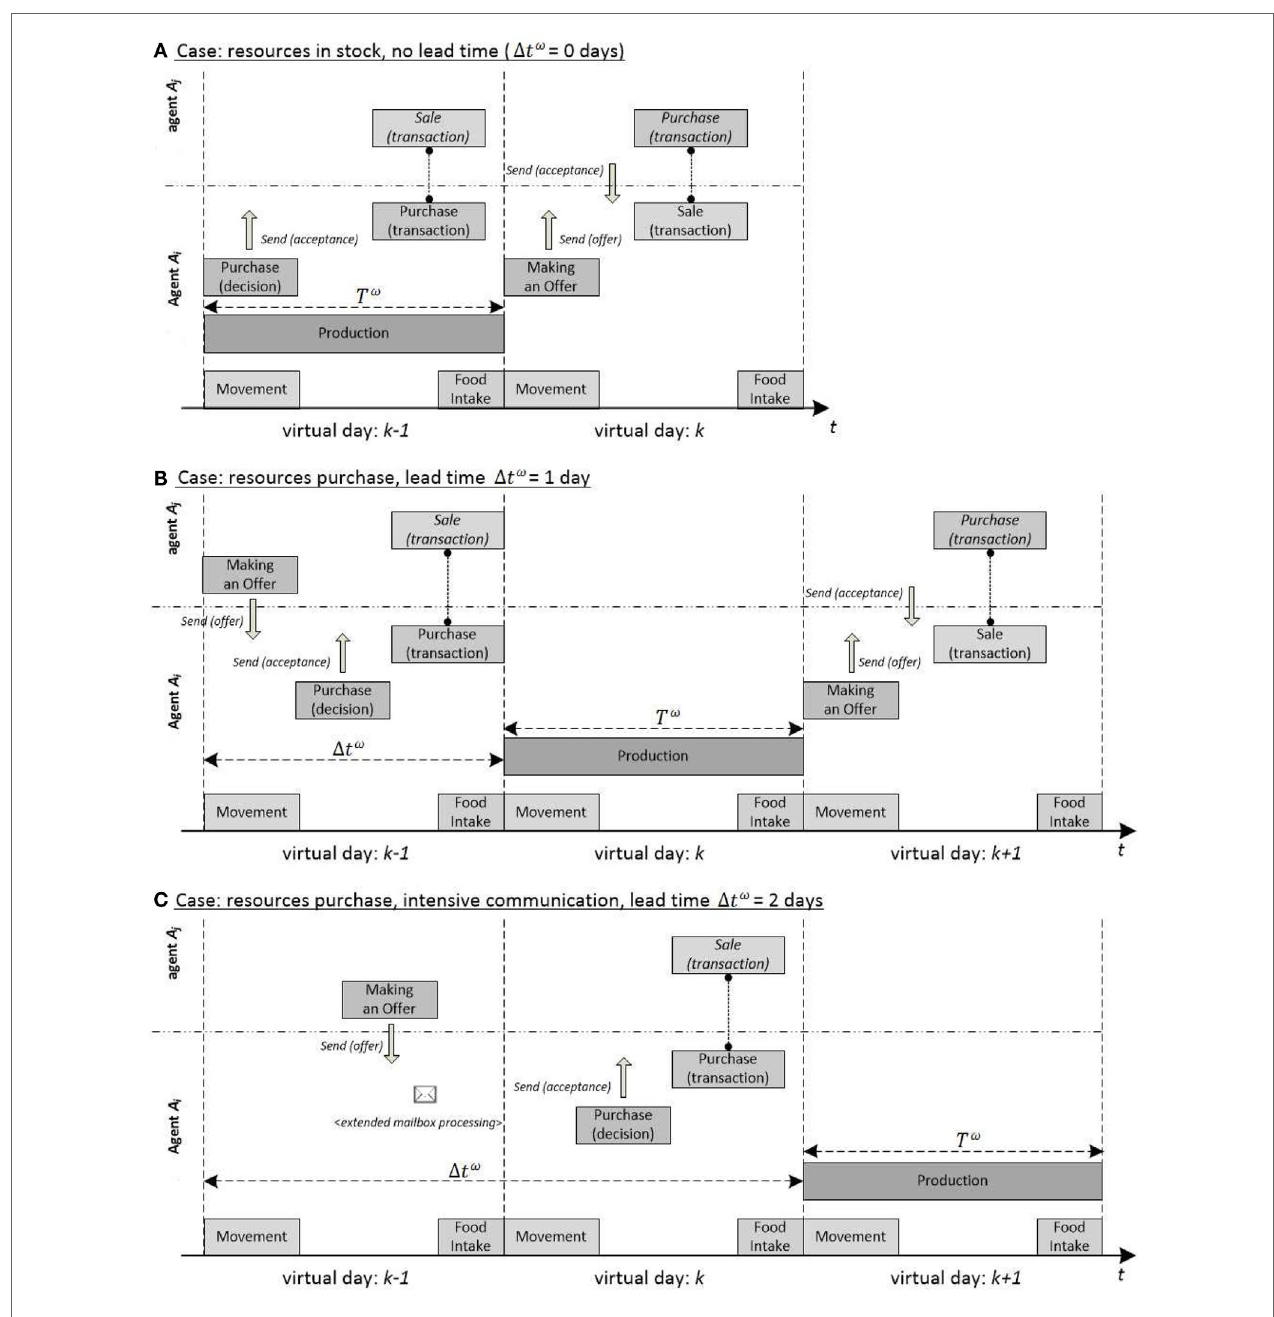
FigUre 8 | Time dependencies from the agent’s perspective